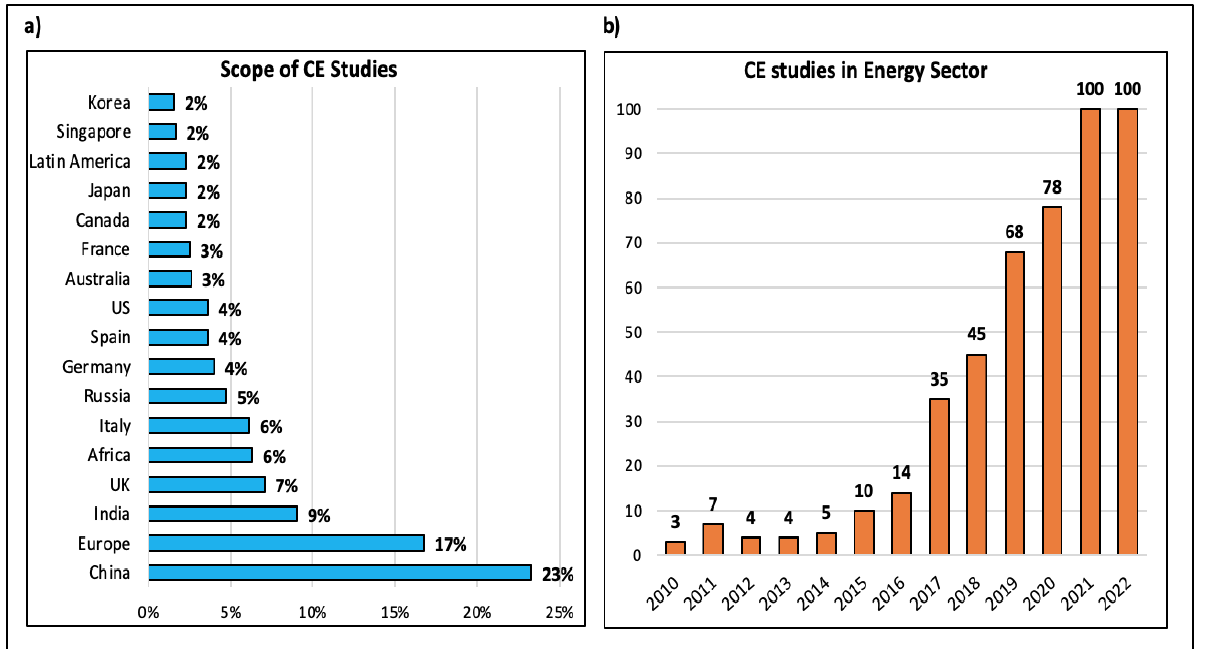
Figure 2. Distribution of studies based on publication year, 2010 – 2022.